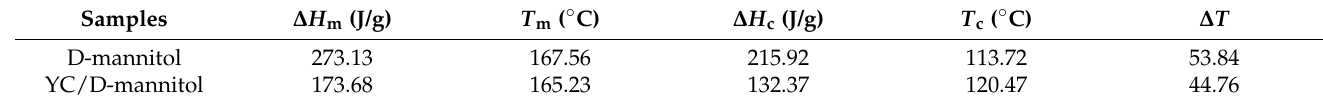
Figure 6. ( a ) DSC curves and ( b ) the thermal characteristics of the YC/D-mannitol ss-PCM. Table 2. Enthalpy and phase change temperature of the YC/D-mannitol ss-PCM.